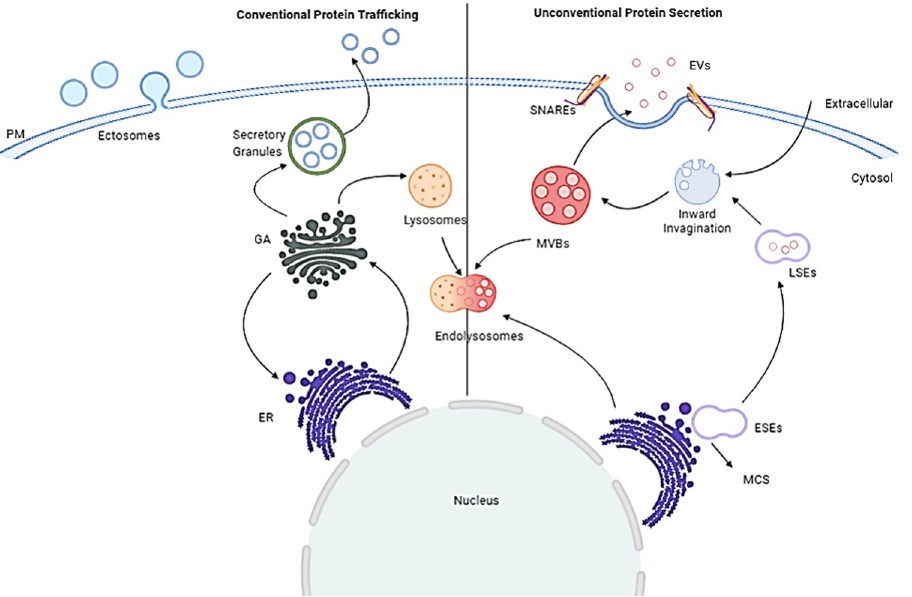
Fig 11. Pictorial depiction of protein secretory pathway: Conventional vs. Unconventional protein pathway.